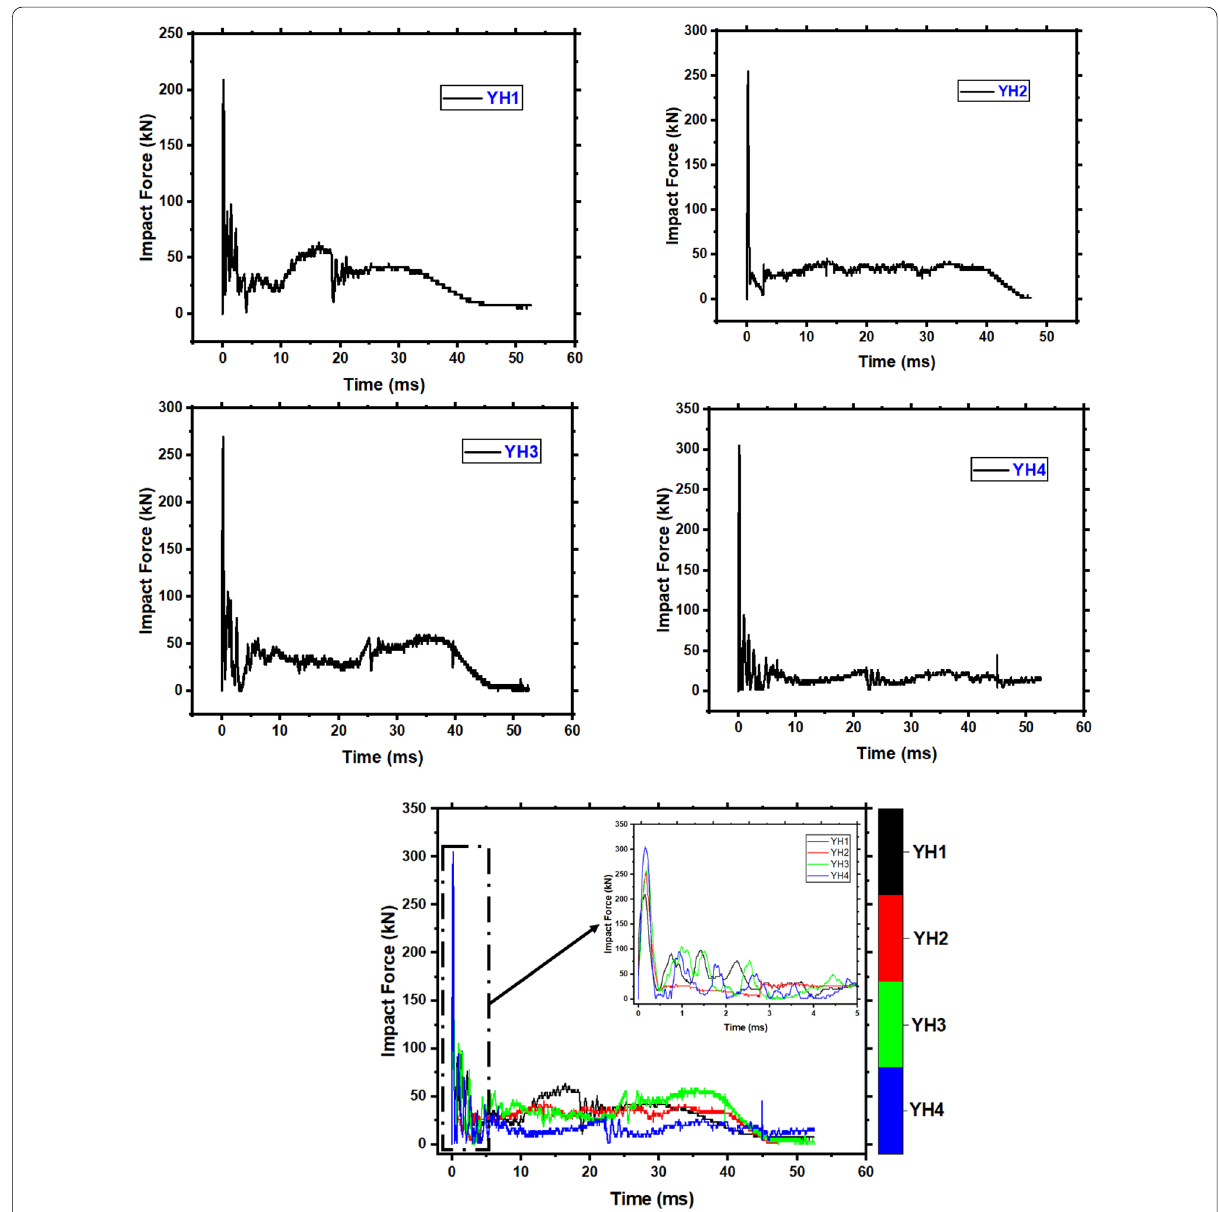
Fig. 13 Time history curve of impact force.